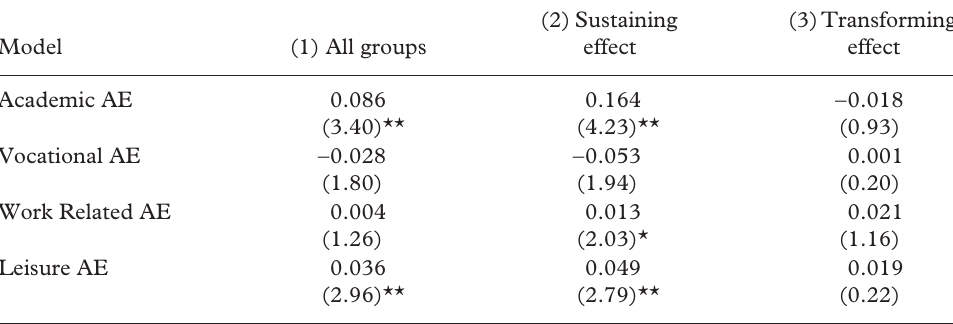
Table 3. Parameter estimates of adult education on cluster membership